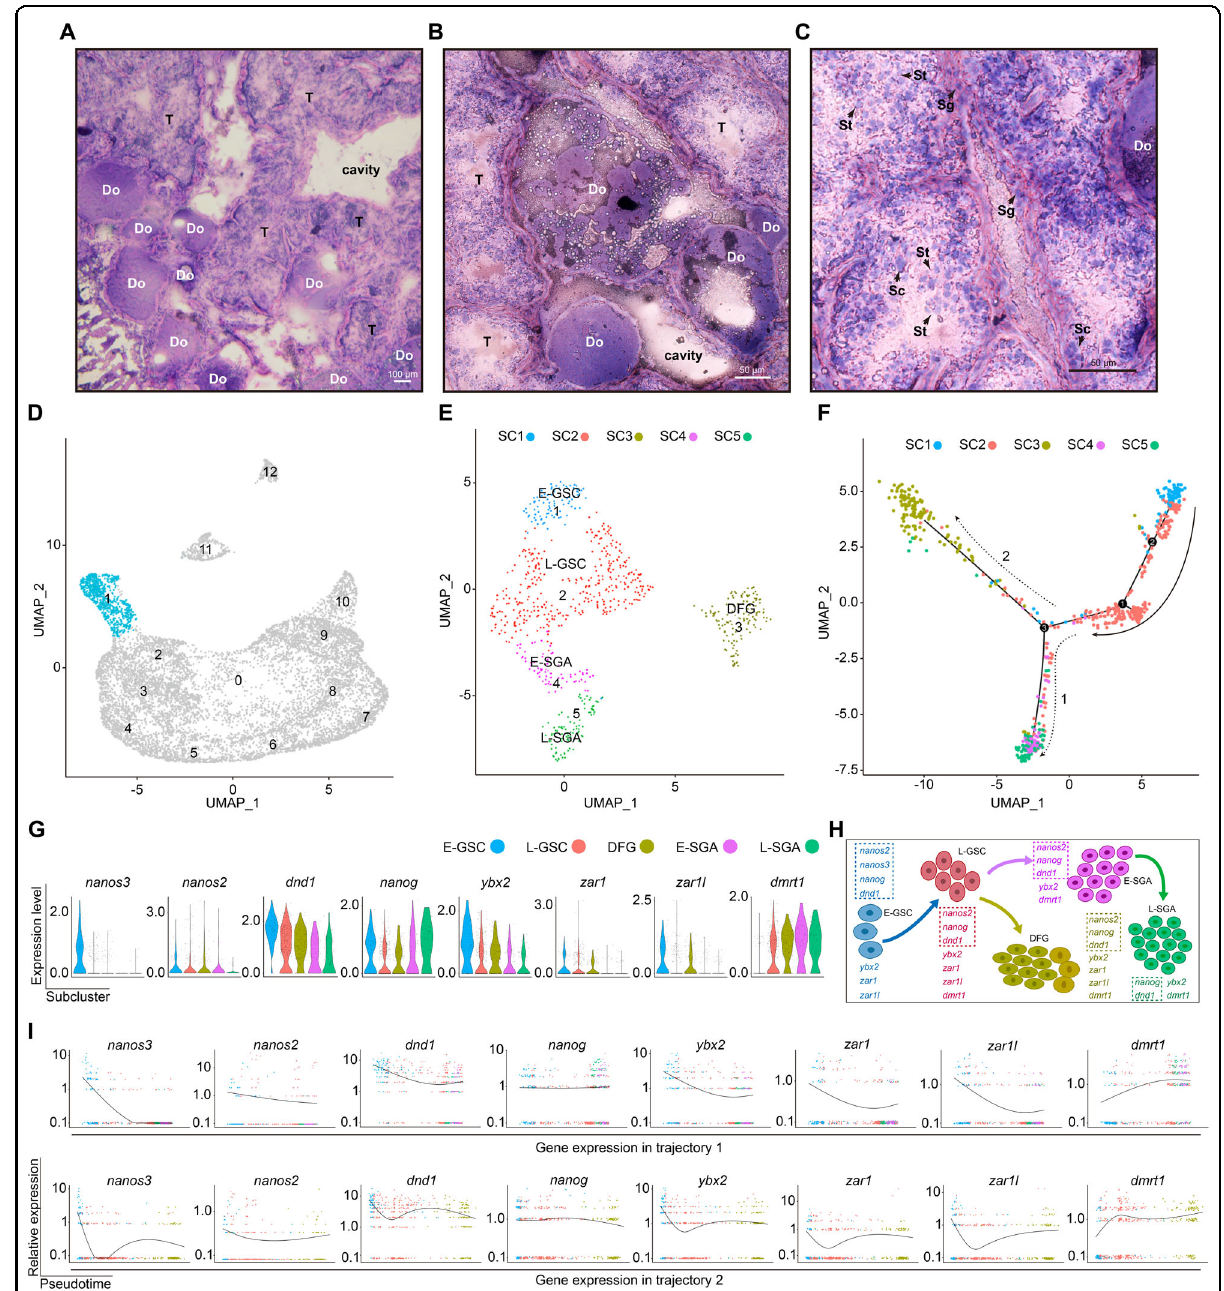
Fig. 1 Identi fi cation of germline stem cells in ovotestis. A Ovotestis section stained by hematoxylin and eosin. DO degrading follicles, T testicular tissue. Scale bar, 100 µm. B Degrading follicles with various phenotypes in ovotestis. Scale bar, 50 µm. C Various spermatogenic cells, but lack of elongate spermatids in ovotestis. Sg spermatogonia, Sc spermatocytes, St round spermatids. Scale bar, 50 µm. D UMAP map showing cells in cluster 1 (blue). E Focused analysis of the cells in cluster 1 by UMAP clustering showed fi ve subclusters: early-GSC (E-GSC), late-GSC (L-GSC), early- spermatogonia A (E-SGA), late-spermatogonia A (L-SGA), and degrading female germline cells (DFG). F Pseudotime trajectory analysis of fi ve subclusters by Monocle revealed two differentiation trajectories (1 and 2). G Violin plots indicating expression levels of representative genes in these subclusters. H Schematic representation of stem cell lineage differentiation from E-GSC, via L-GSC, to L-SGA or to female germline stem cells. Stem cell factors are circled by dot lines. I Expression patterns of representative genes along the pseudotime axis. Top panels indicate pseudotime trajectory 1, and bottom panels show pseudotime trajectory